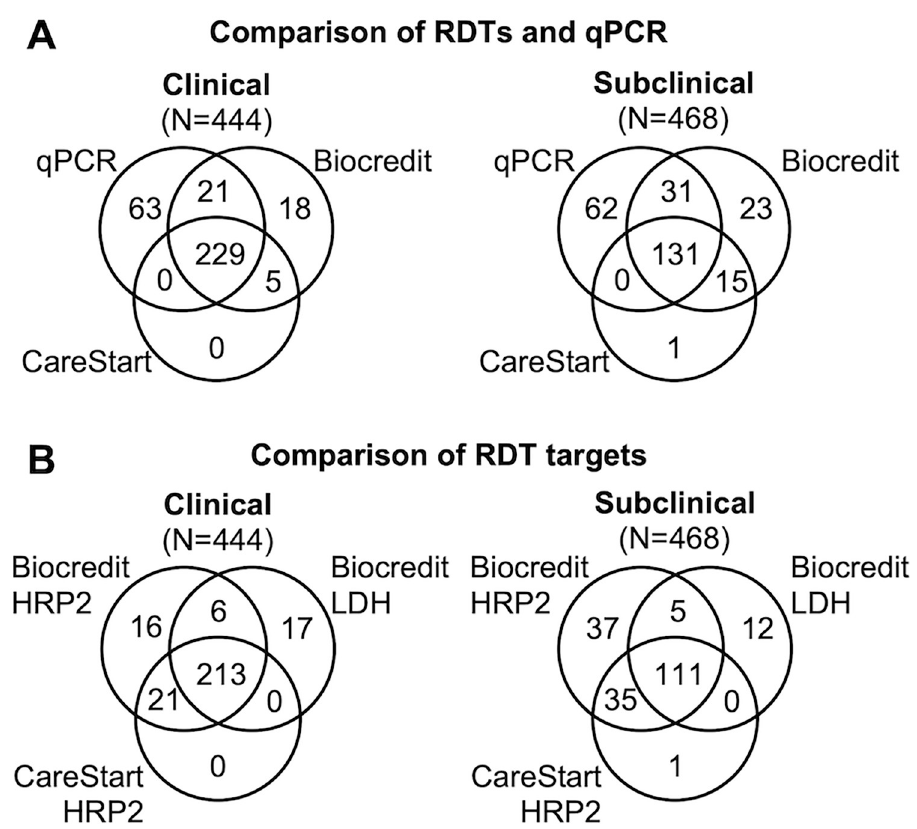
Fig 1. Correspondence among qPCR, and different RDTs and RDT targets. For panel A, when either band on the Biocredit RDT was positive it was recorded as positive. Panel B includes false-positive RDTs that were negative by